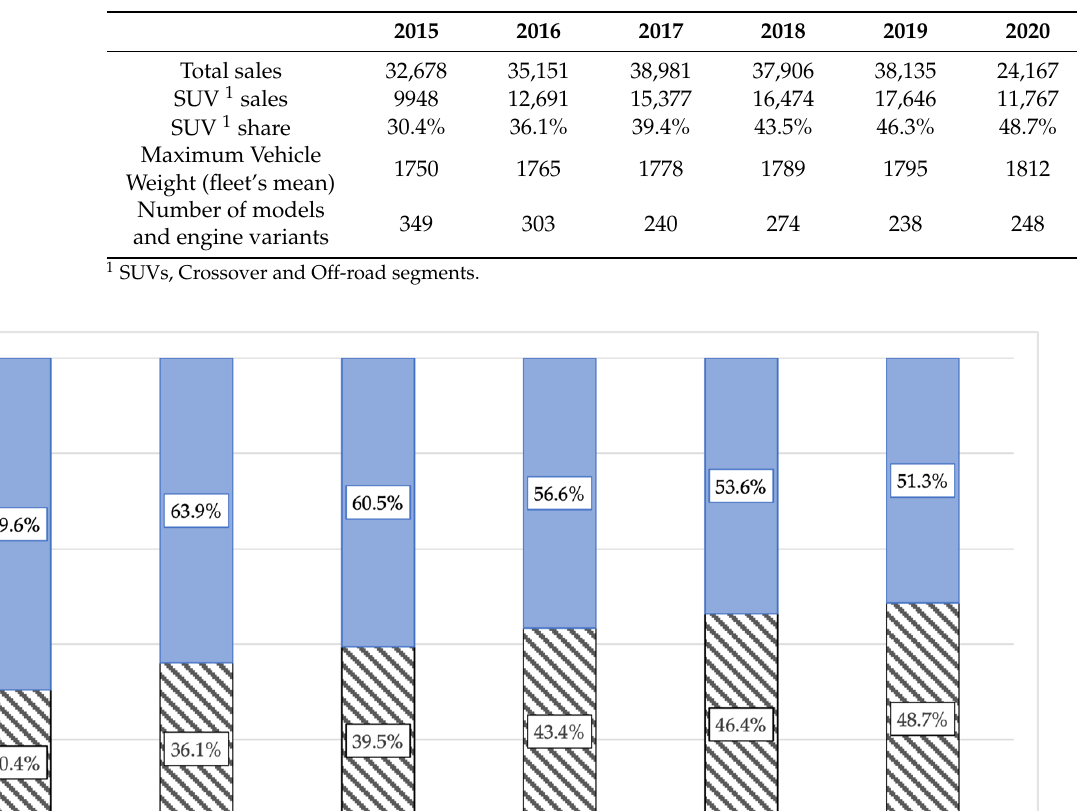
Table 2. The Canary Islands SUVs market figures for private buyers.